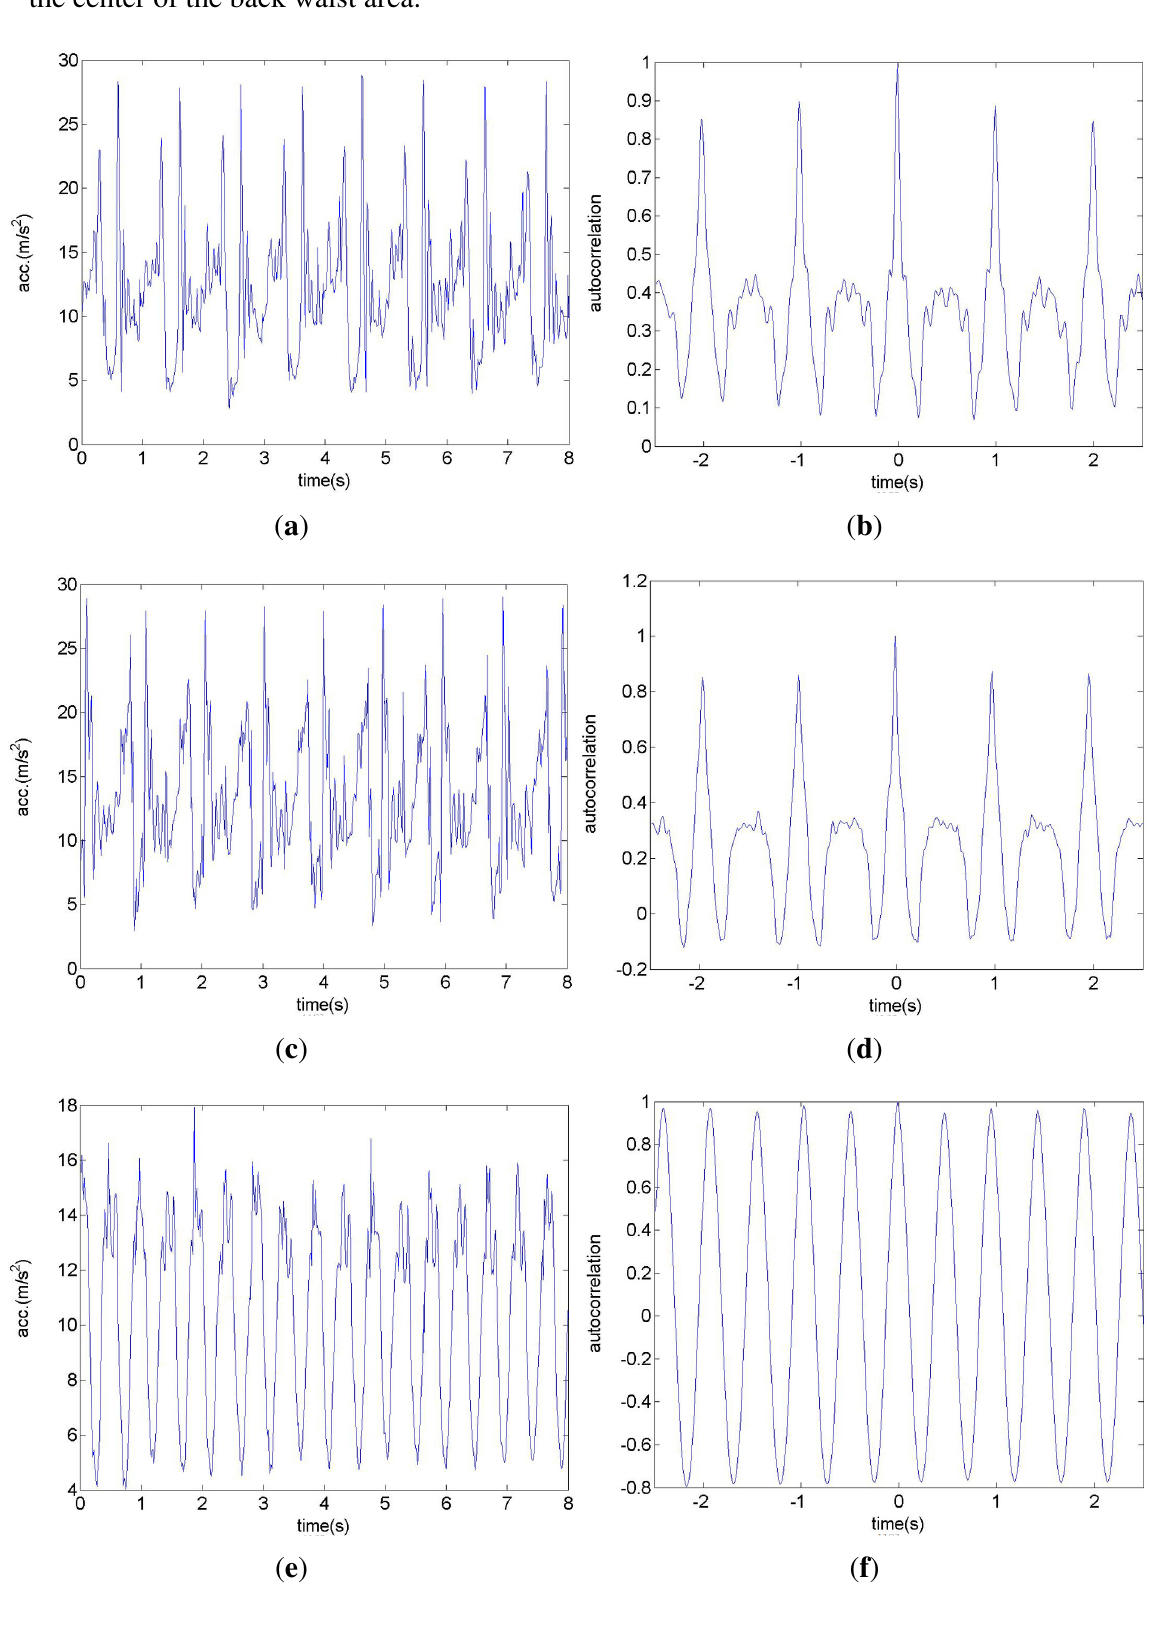
Figure 7. Linear acceleration and autocorrelation curves. ( a ) and ( b ) correspond to the data collected by the iPhone in left pant pocket. ( c ) and ( d ) correspond to the data collected by the iPhone in right pant pocket. ( e ) and ( f ) correspond to the data collected by the iPhone in the center of the back waist